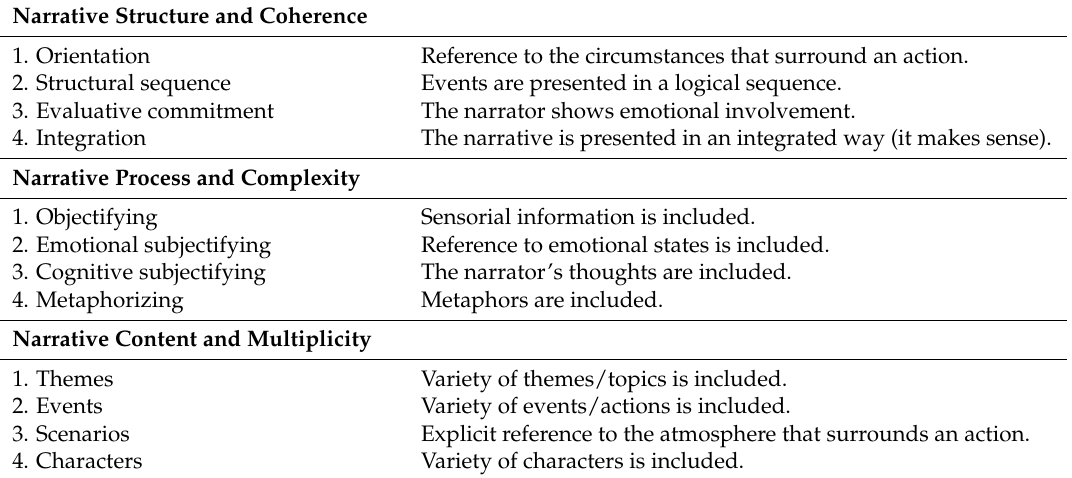
Table 1. Gonçalves et al.’s (2001a, 2001b, 2001c) narrative guidelines by dimensions and